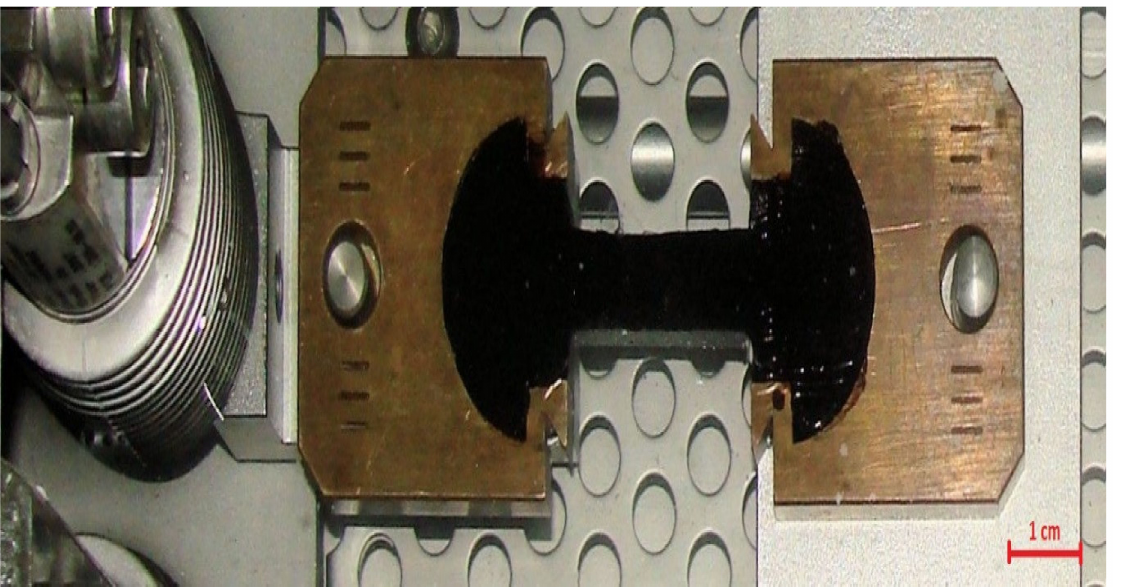
Figure 2. Asphalt binder sample during the ductilometer